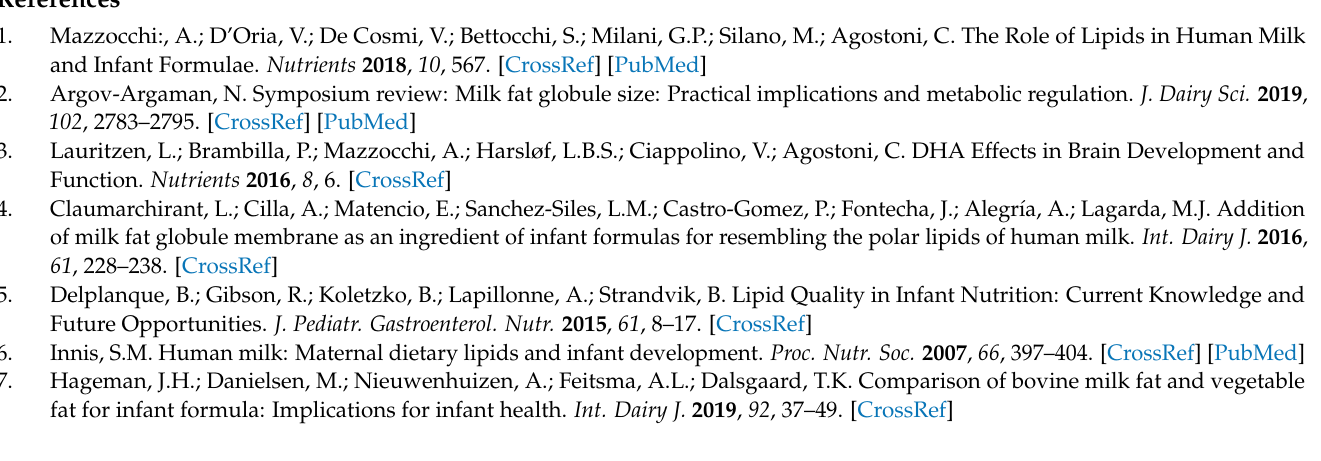
Table S2: The content of differential fatty acids in IF1-IF5 before and after